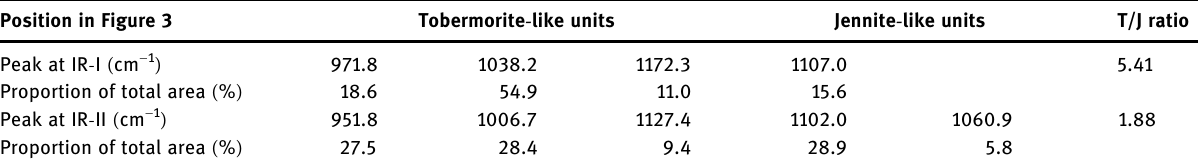
Table 1: Deconvolution results of tobermorite - like and jennite - like nanocrystals in C – S – H based on Figure 6 Position in Figure 3 Tobermorite - like units Jennite - like units T/J ratio